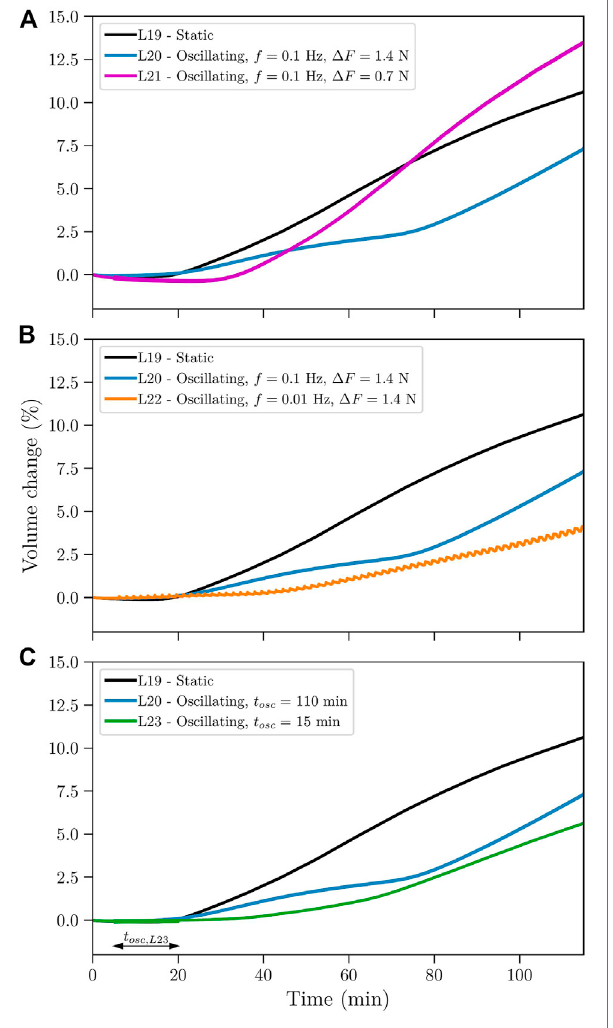
FIGURE 6 | (A) Segmented images of the experimental products from the four experiments presented in Figure 4 . Glass is in black, the ceramic crucible is in gray, core bubbles are in blue and rim bubbles are in orange. Original SEM images used to produce these can be found in the Supplementary Material . (B) Bubble fractions from the images in (A) , divided between core bubbles (blue) and rim bubbles